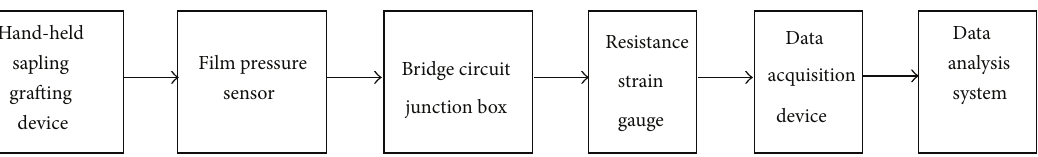
Figure 9: Flow diagram of the test circuit.